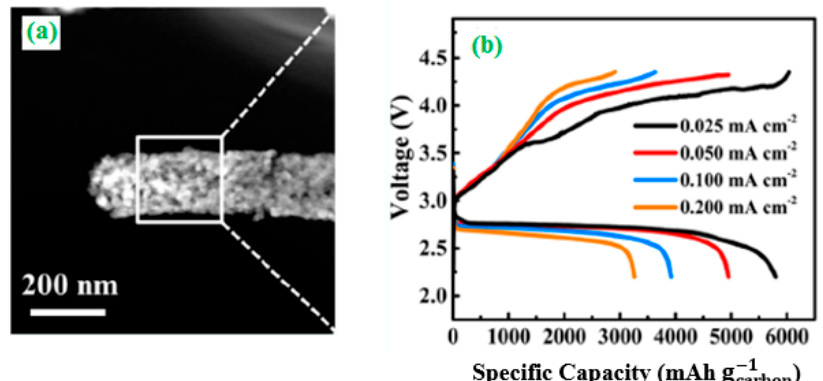
Figure 5. ( a ) Transmission electron microscopy and elemental distribution mapping (HAADFSTEM) image of hierarchical mesoporous-macroporous La 0.5 Sr 0.5 CoO 3 − x (HPN–LSC) ( b ) Galvanostatic discharge / charge curves of Li − O 2 batteries with the HPN–LSC / KB electrode at various current densities. Reprinted with permission from [69]. Copyright (2015), American Chemical Society.